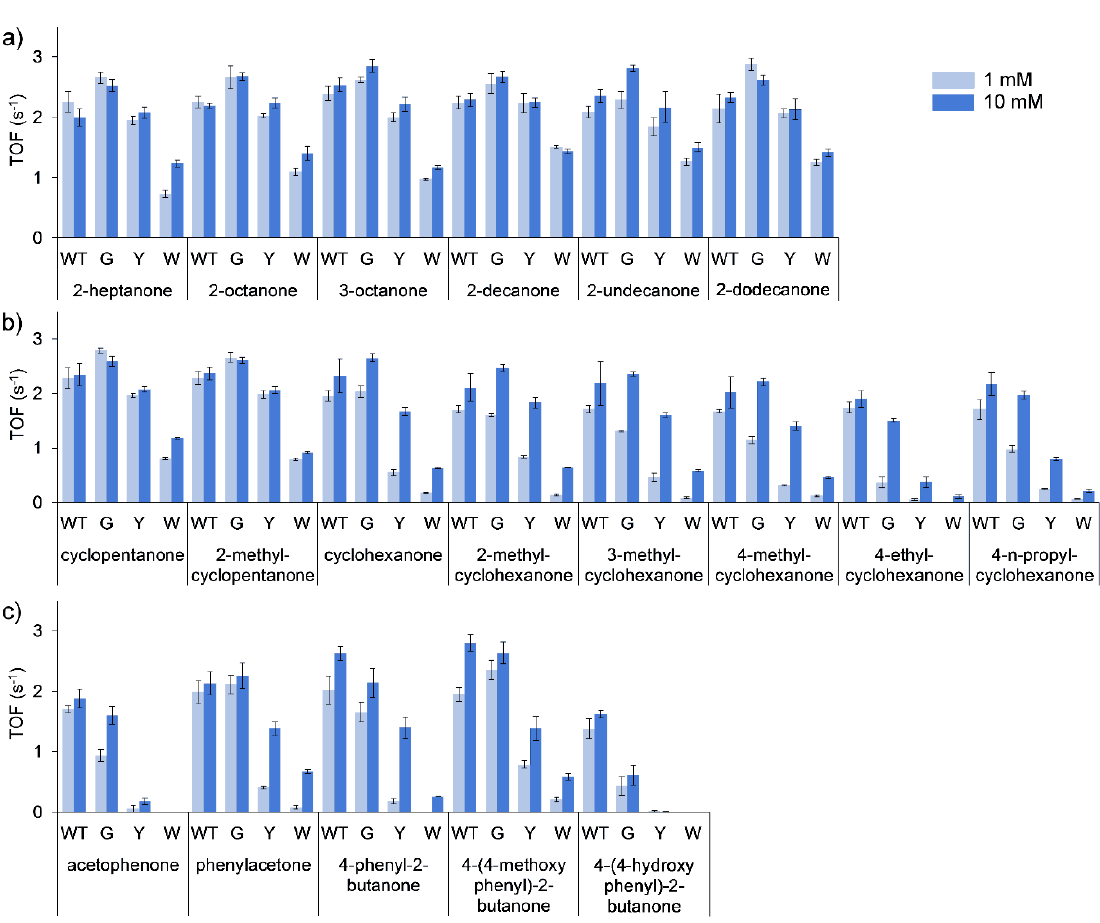
Figure 3. Effect of mutation of Thr513 (WT) to Gly (G), Tyr (Y) and Trp (W) on initial activity (TOF, k obs ) of BVMO AFL210 towards linear ( a ), cyclic ( b ) and aromatic ( c ) ketones. Reaction conditions: 1 mL aqueous reaction mixtures containing 0.395 µM BVMO, 0.3 mM NADPH, buffer: 100 mM Tris-HCl (pH 9), 100 mM NaCl, substrate: 1 mM (light blue) or 10 mM (dark blue), 1% (v/v) methanol, 25 °C. Catalysts 2020 , 10 , x FOR PEER REVIEW